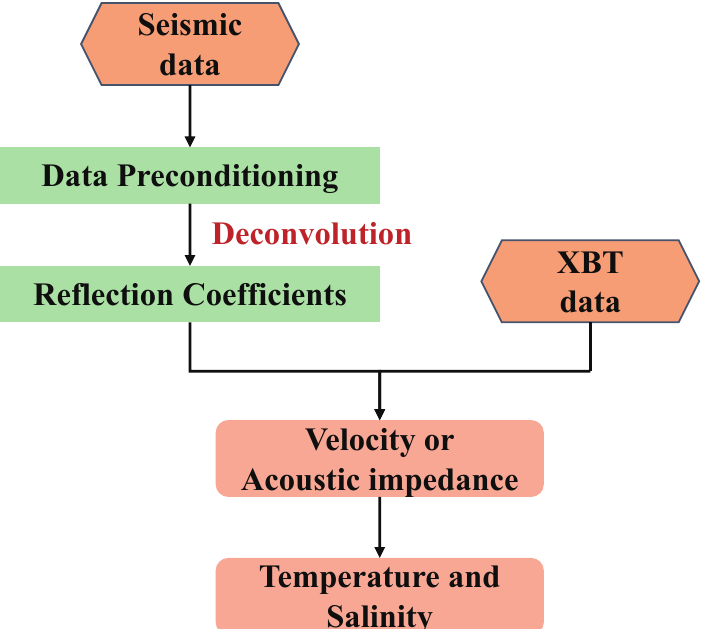
Figure 9. Typical workflow of the deconvolution inversion